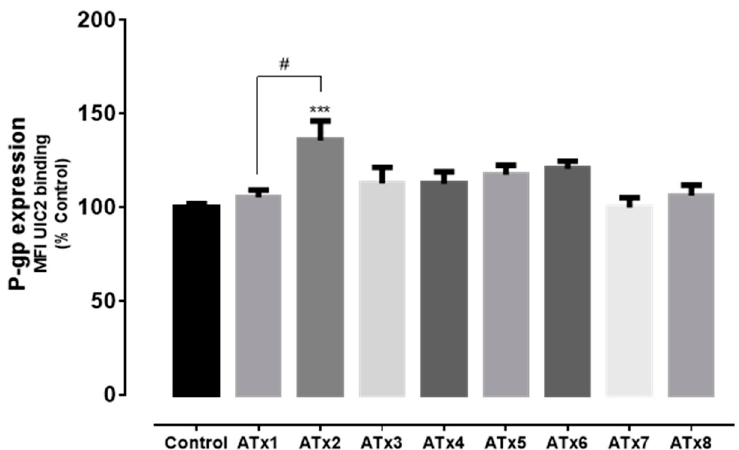
Figure 4. Flow cytometry analysis of P-gp expression levels in Caco-2 cells exposed to ATxs 1 – 8 (20 µ M) for 24 h. Results are presented as mean ± standard error mean (SEM) from 5 independent experiments (performed in duplicate). Statistical comparisons were made using One-way ANOVA, followed by Tukey’s multiple comparisons test (*** p < 0.001 vs. control (0 µ M); # p < 0.05 for ATx 1 (+) vs. ATx 2 ( − )).